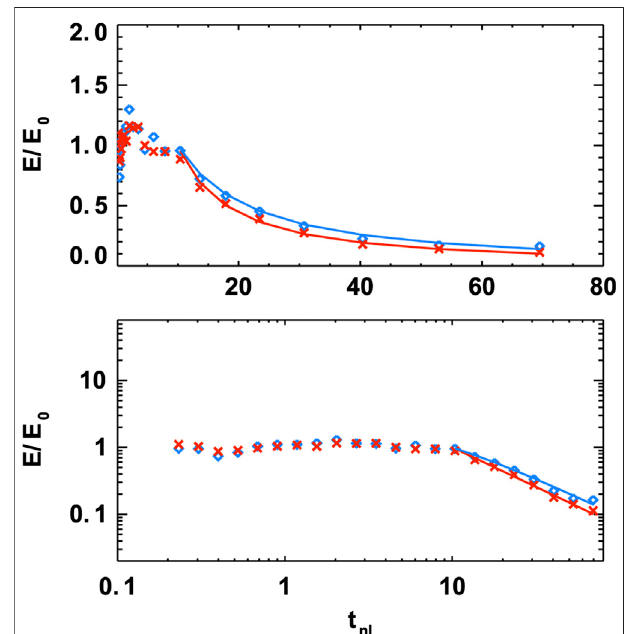
FIGURE 9 | Average downstream evolution of the kinetic (red crosses) and magnetic (blue diamonds) energies for the set of 174 IP shocks analyzed by[105].Upper/lowerpanelshowstheevolutioninalinearscale/log-logscale, respectively. E 0 signi fi esthatthepro fi leofeachshockwasnormalizedby its immediate downstream value. Corresponding colored lines show the fi t by a phenomenological power law function de fi ned by Eq. 5 . Image adapted from [105] and reproduced by permission of the